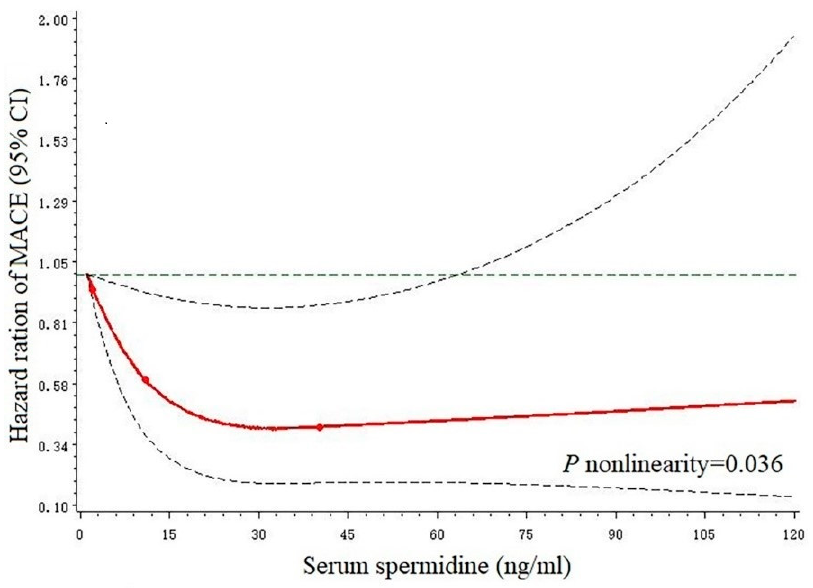
Figure 1. Relationship of serum spermidine with MACE in patients with AMI ( n = 377). Hazard ratios and 95% CIs were derived from restricted cubic spline regression, with knots placed at the 5th, 50th, and 95th percentiles of the distribution of serum spermidine levels. Red lines indicate hazard ratios, the green line indicates the reference line (The minimum of spermidine as a reference point), and dashed lines indicate 95% CI. Hazard ratios were adjusted for the same variables as model 2 in Table 3. MACE major adverse cardiac events, CI confidence interval, AMI acute myocardial infarction.